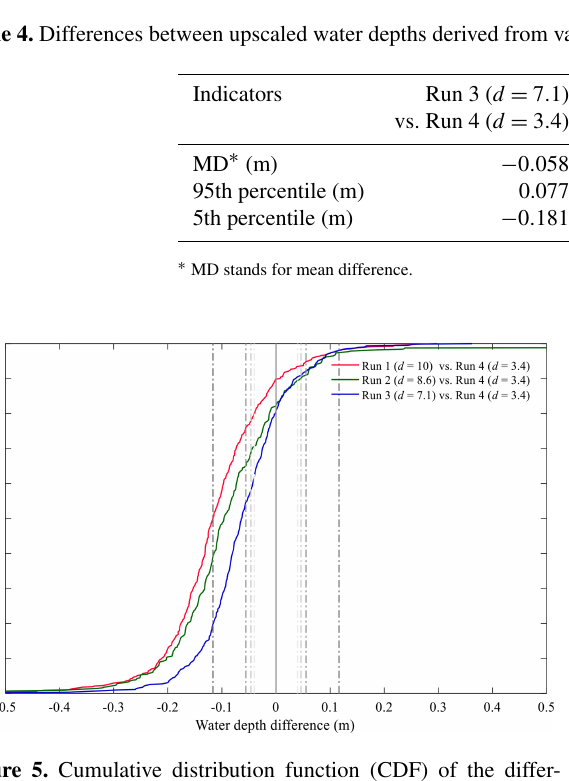
Figure 5. Cumulative distribution function (CDF) of the differ- ences between upscaled water depths from the various model runs of Araud (2012); the grey lines represent the upscaled measurement uncertainties with various e V (the larger the e V , the deeper the line